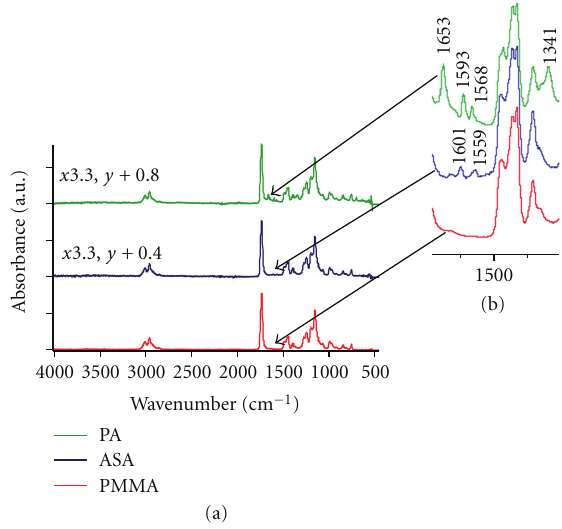
Figure 4: Absorbance as a function of wavenumber—infrared spec- tra of undoped precipitated PMMA (red), ASA capped nanocrystals incorporated into precipitated PMMA (blue), and PA capped nanocrystals incorporated into precipitated PMMA (green) in the range of 4000–500 cm − 1 (a) and inset—range 1700–1300 cm − 1